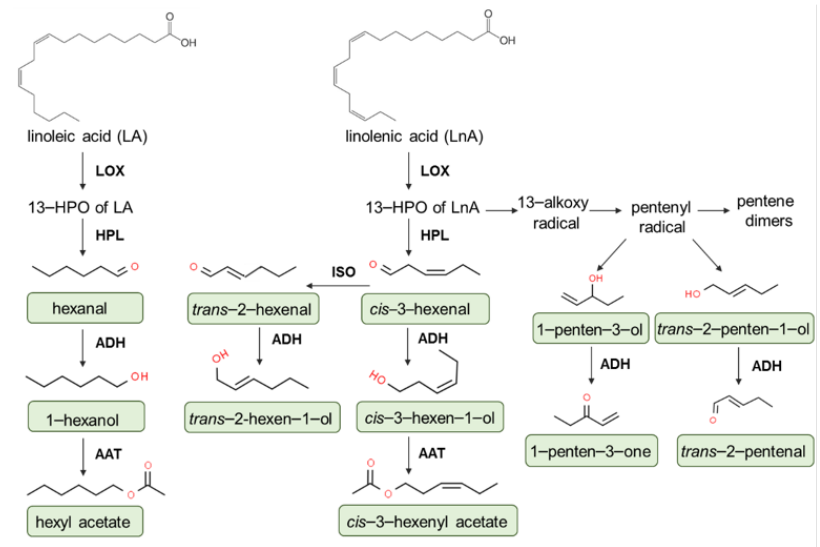
Figure 3. Lipoxygenase pathway (LOX) involved in the production of VOO volatile compounds. Ab- breviations: AAT, alcohol acyltransferase; ADH, alcohol dehydrogenase; 13–HPL, 13–hydroperoxide lyase; ISO,